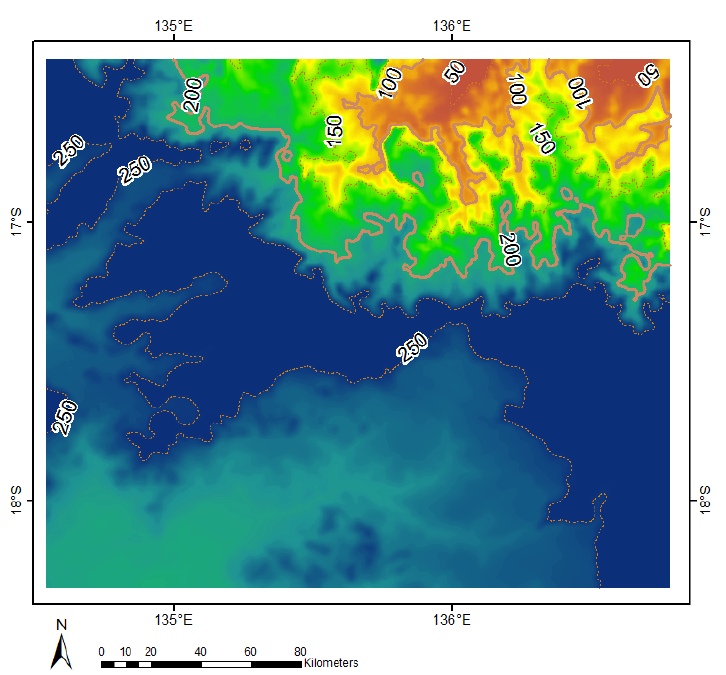
Figure 2. SRTM DEM and calculated contour lines in 50 m intervals showing the Landsat footprint of path 102 row